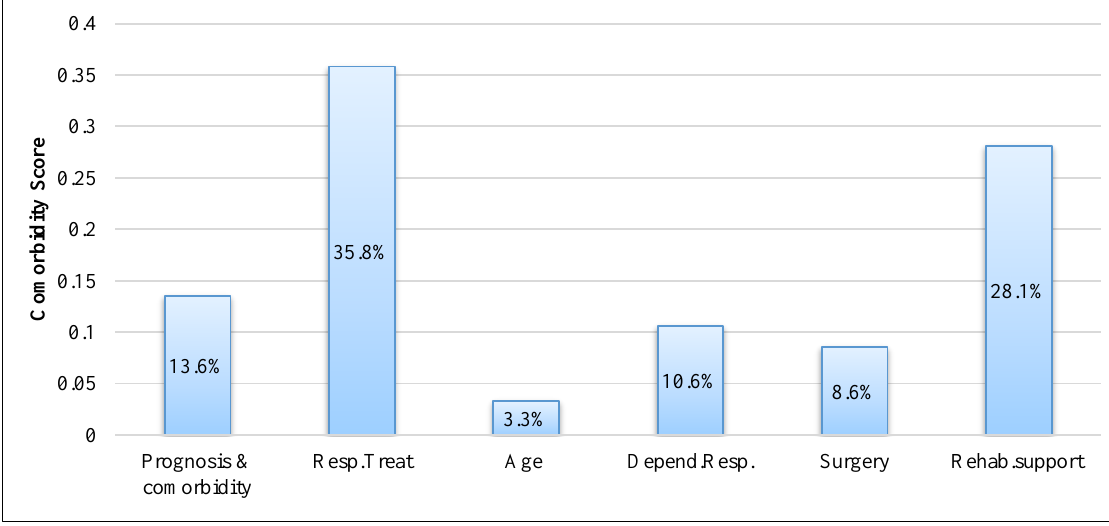
Figure 4. Expert 1 Evaluation (Factor